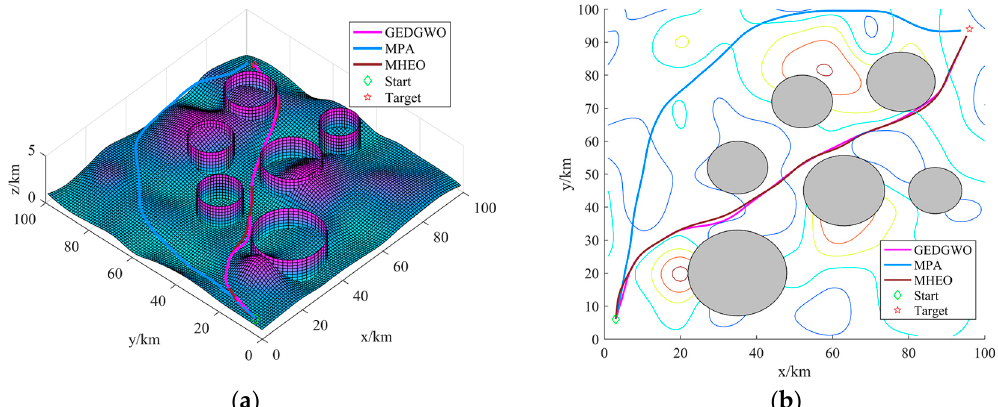
Figure 5. The best path of each algorithm: ( a ) path in three-dimensional space; ( b ) path in three-dimensional space.